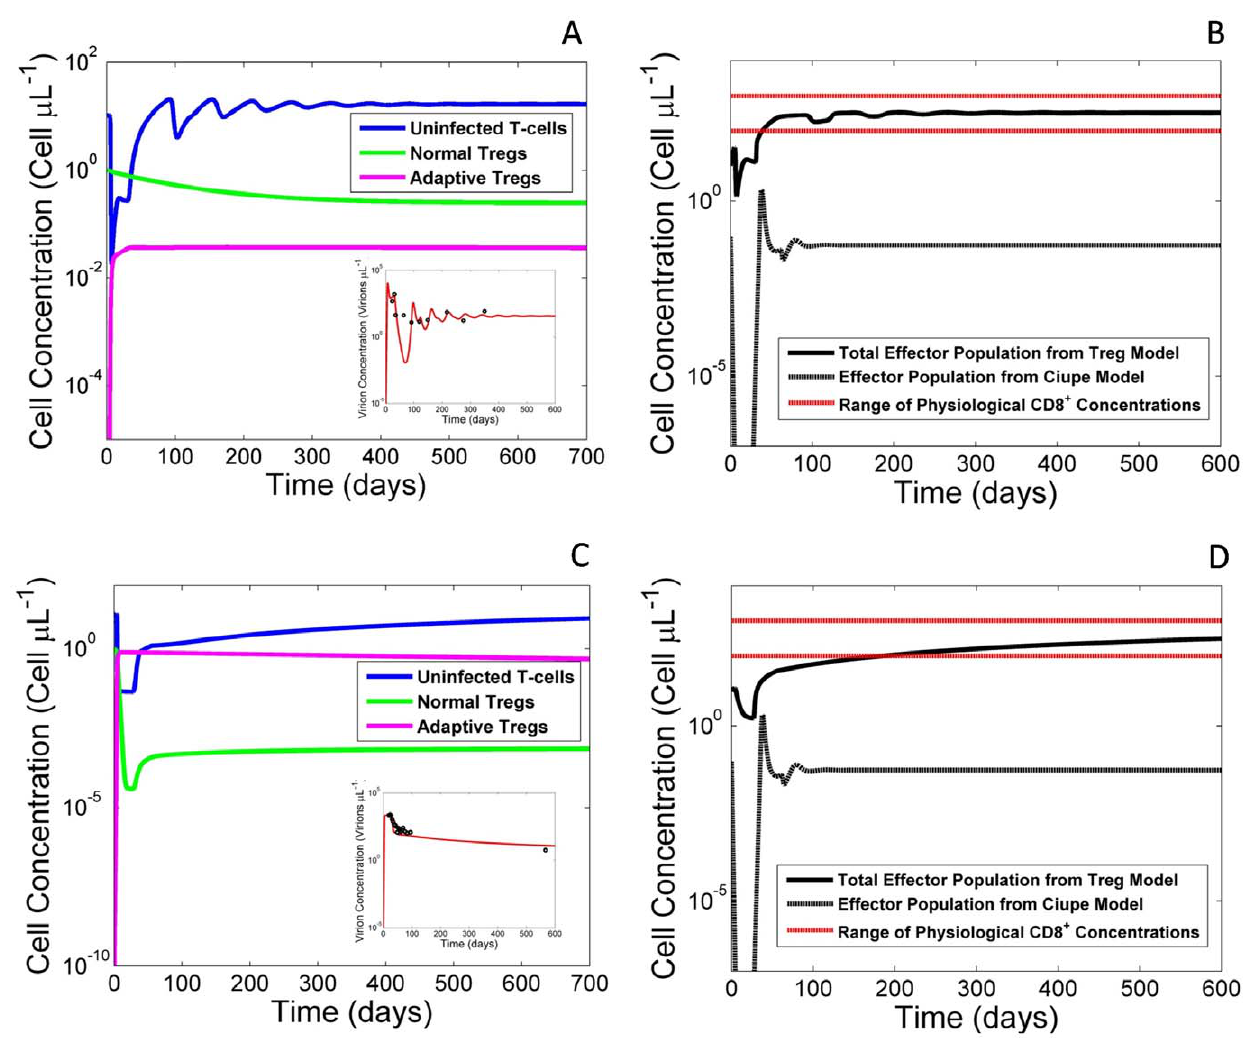
Figure 1. Treg model shows improved effector cell dynamics over previously published fits. (A,C) Plot of modeled uninfected T-cell population (blue), normal Treg (green) and adaptive Treg populations (purple). Models correspond to best fits to the viral load data from two separate representative patients. (inset) Patient data is shown (circular data points), and viral load is shown (red). Parameter values for simulations can be found in Table 1. (B,D) Comparative plots of effector populations using Treg model as compared to a previously published model [9] as well as physiological ranges for effector cells [10] as seen by the red horizontal lines in B and D. In all cases, we notice that our model does not dip to unrealistic ranges initially as does the Ciupe model. However, the viral load fits between both models are nearly the same suggesting a degree of robustness between both models.